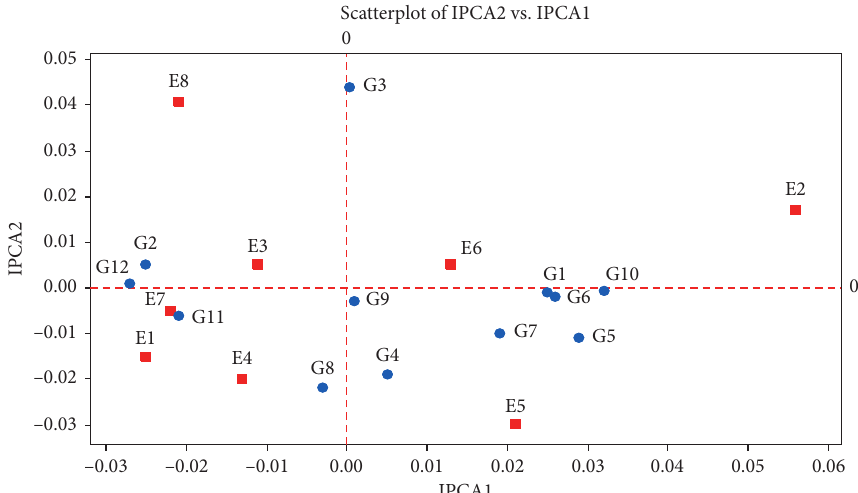
Figure 2: AMMI 2 biplot for the two main axes of interaction (IPCA 2 vs. IPCA 1) in 12 hybrids of Zea mays L. from eight environments. G1: KSC703; G2: KSC260; G3: KSC705; G4: KSC400; G5: KSC706; G6: KSC704; G7: KSC707; G8: DC370; G9: SC647; G10: SC302; G11: SC604; G12: SC301; E1: Karaj Year 1; E2: Karaj Year 2; E3: Birjand Year 1; E4: Birjand Year 2; E5: Shiraz Year